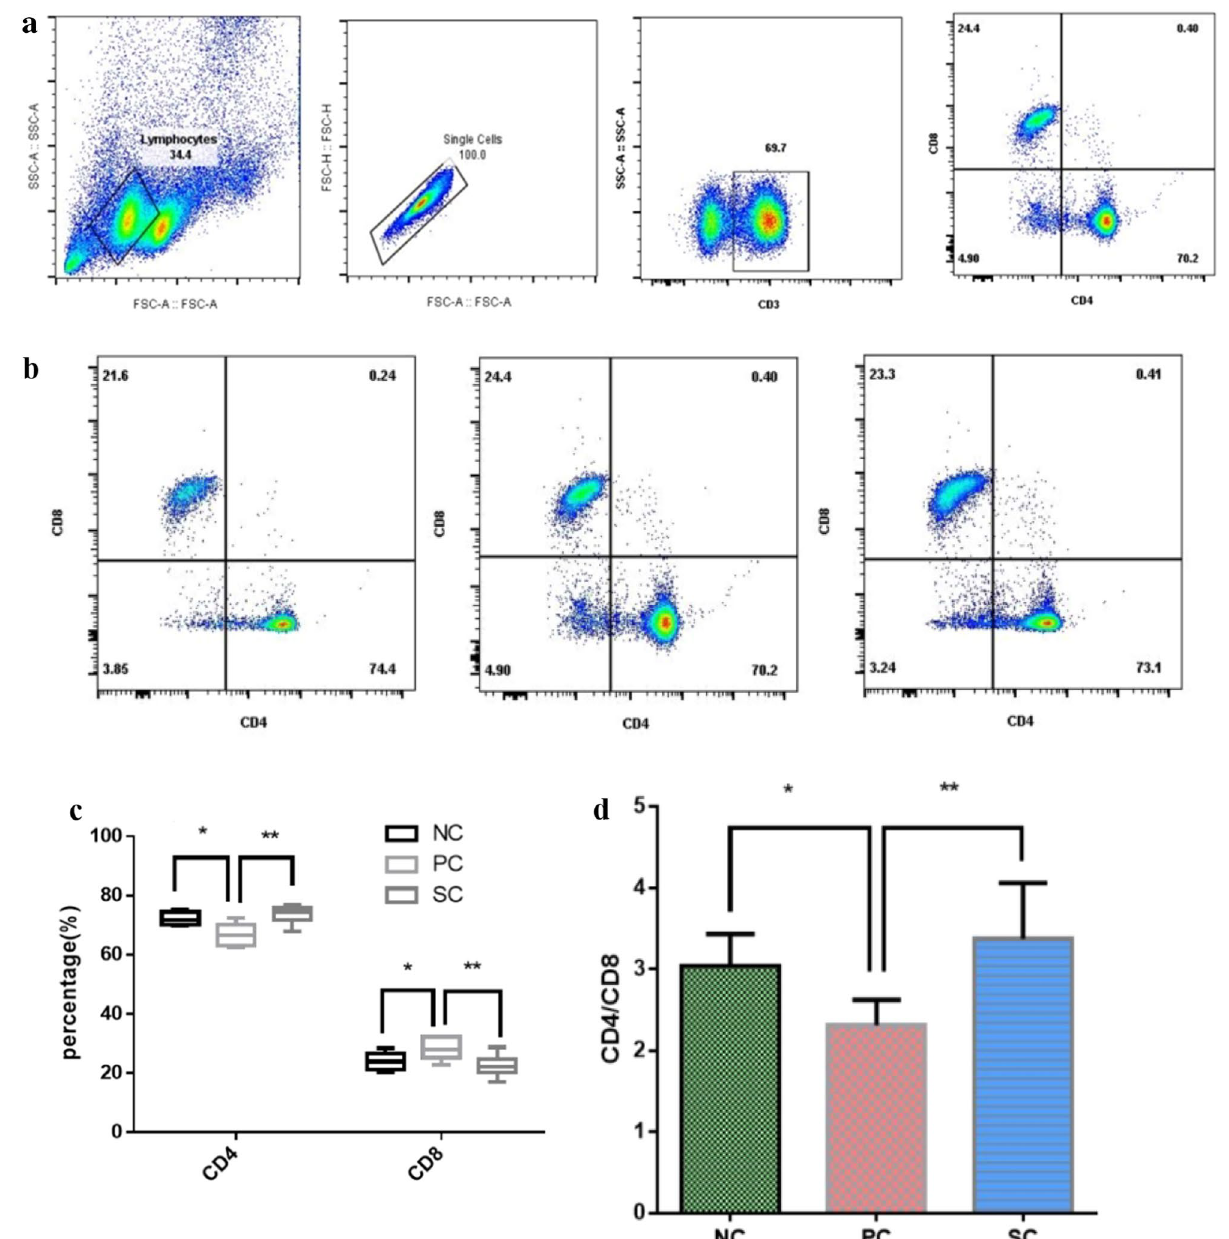
Figure 6. Immunotherapy can affect the number of CD4+ T cells and the ratio of CD4+/CD8+ cells in the peripheral blood of AR mice. Flow cytometry was used to determine the number of CD4+ and CD8+ T cells in the peripheral blood of mice in each group ( b ). The circle-gate strategy is shown in Figure ( a ). ( c ) is the percentage of CD4+ T and CD8+ T cells in peripheral blood, and d is the ratio of CD4+ to CD8+ cells in each group. *P < 0.05, **P <